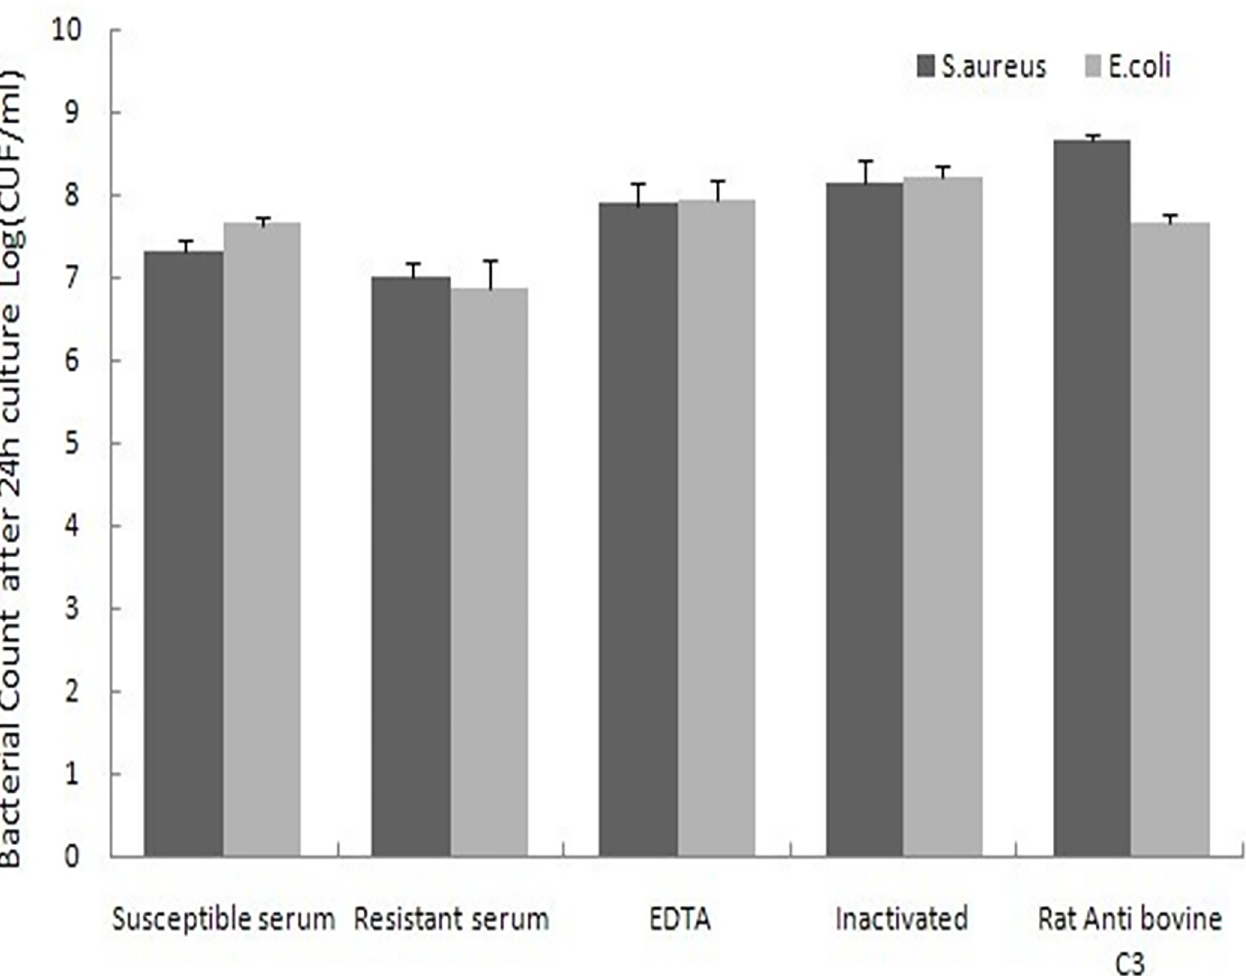
Fig 5. Serum antibacterial activity of resistant and susceptible cows and neutralization of antibacterial activity from resistant subjects by specific inhibition of C3. The differences in Log (CFU/ml) between resistant serum and others were highly significant ( P < 0.001). Data are means ± standard